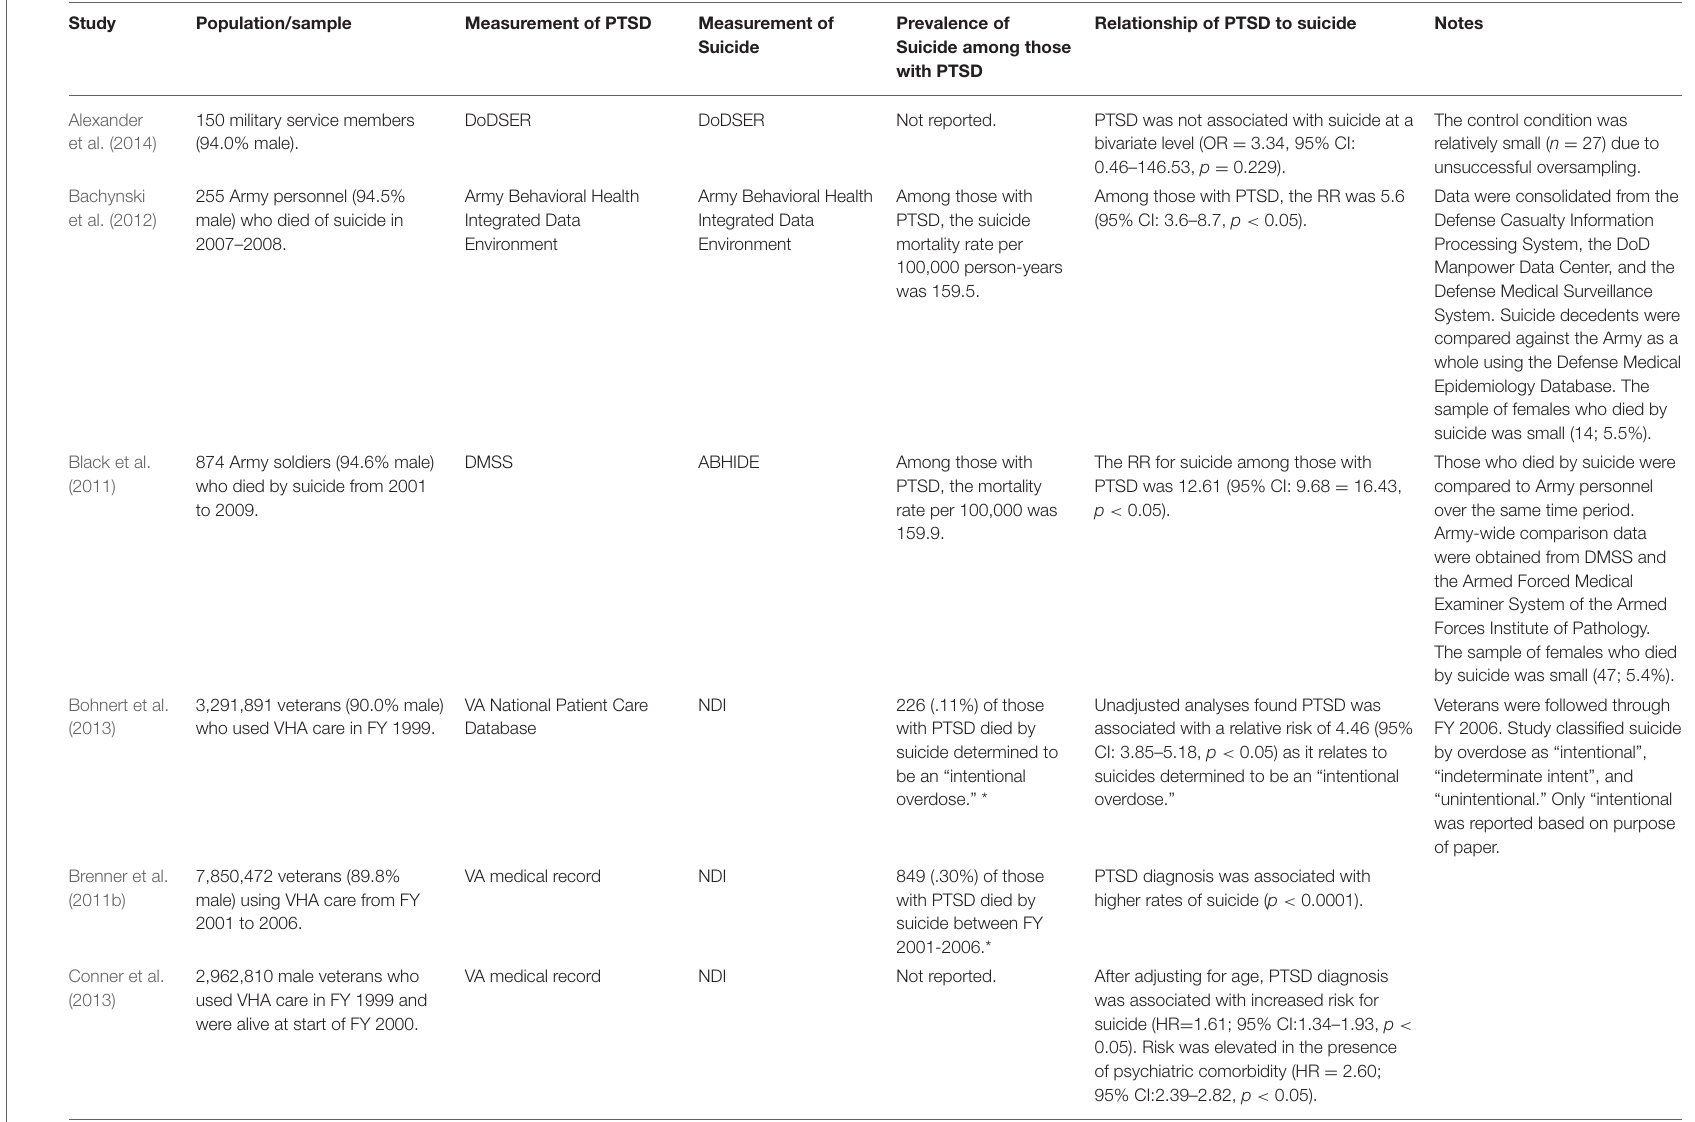
TABLE 4 | Suicide among Military Personnel and Veterans with PTSD ( n =